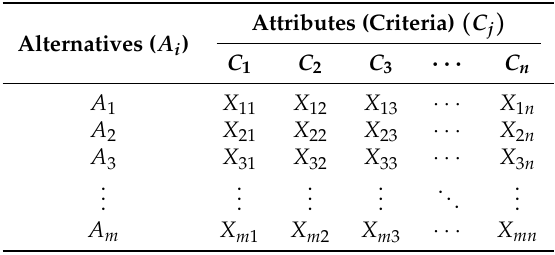
Table 1. Decision matrix for MADM